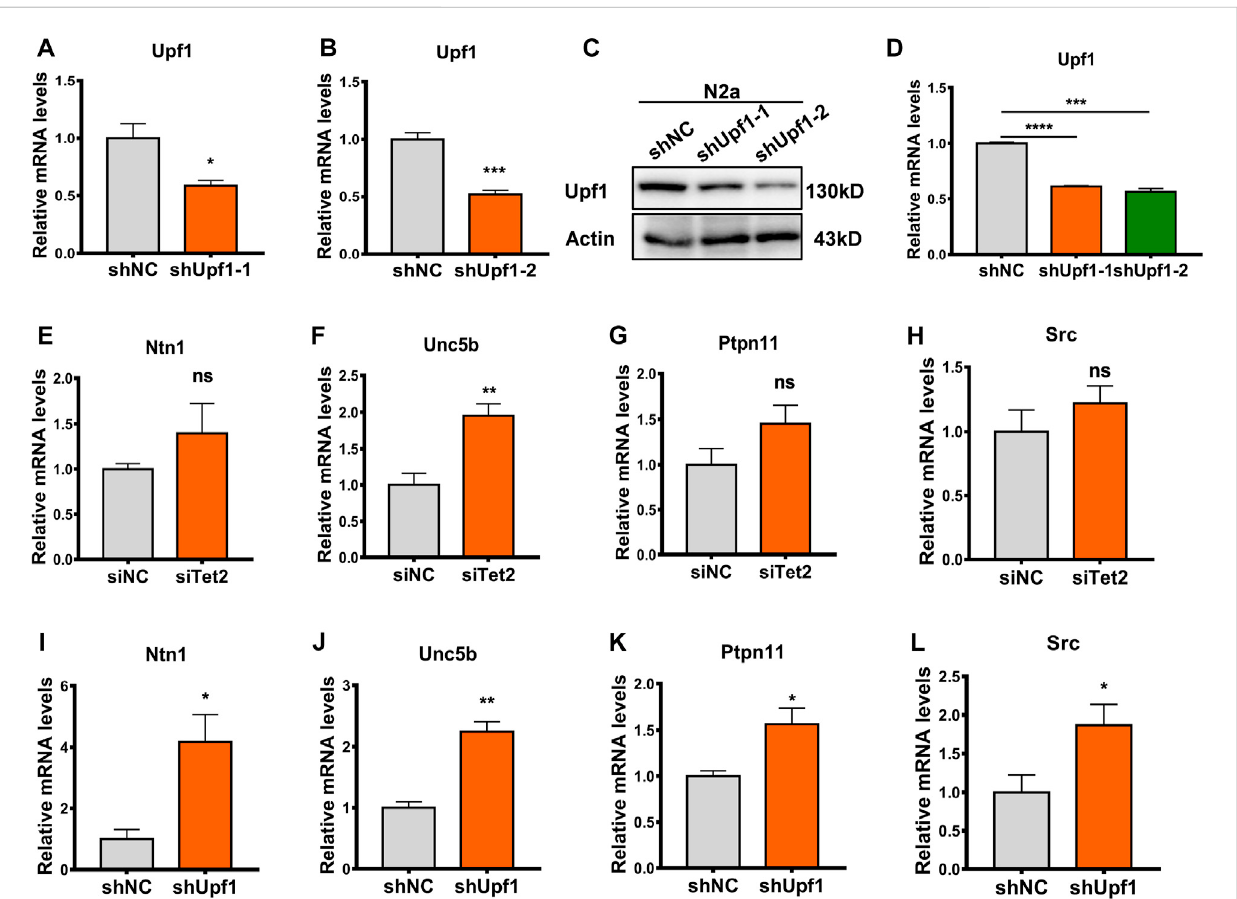
FIGURE 6 Unc5b reducedafter knockdown ofTet2orUpf1. (A) RT-PCRdetection ofthemRNA level ofknockdown Upf1intheconstructed shUpf1-1 plasmid. n =3,* p < 0.05. (B) RT-PCRdetectionofthemRNAlevelofknockdownUpf1intheconstructedshUpf1-2plasmid. n =4,*** p < 0.001. (C,D) Westernblot detection of the protein level of knockdown Upf1 in the constructed shUpf1-2 plasmid. n = 3, *** p < 0.001, **** p < 0.0001. (E – H) RT-PCR detection of mRNA levels of Ntn1 (E) , Unc5b (F) , Ptpn11 (G) , and Src (H) before and after knockdown of Tet2. n = 4 – 6. ns: no signi fi cant, ** p < 0.01. (I – L)